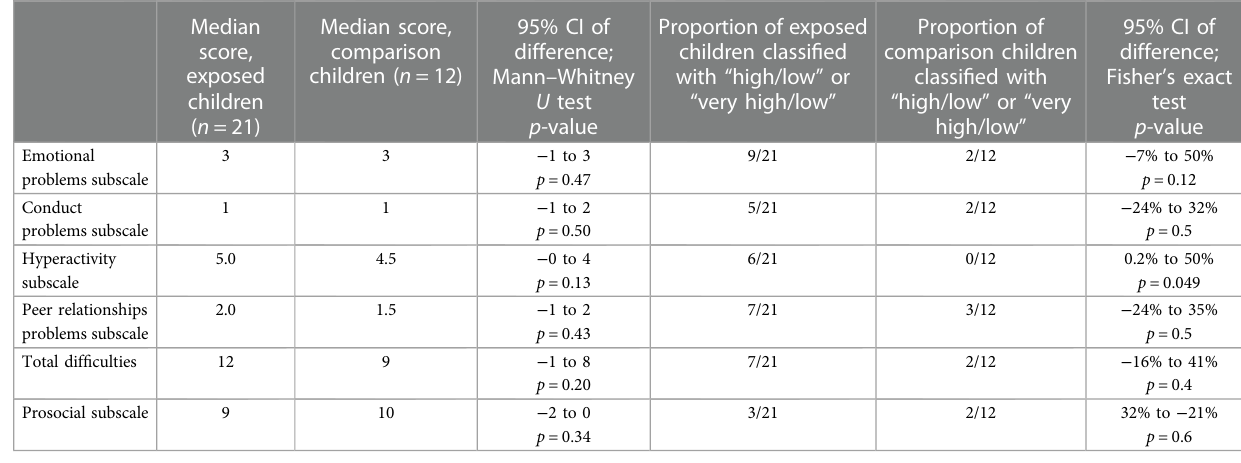
TABLE 3 SDQ results.